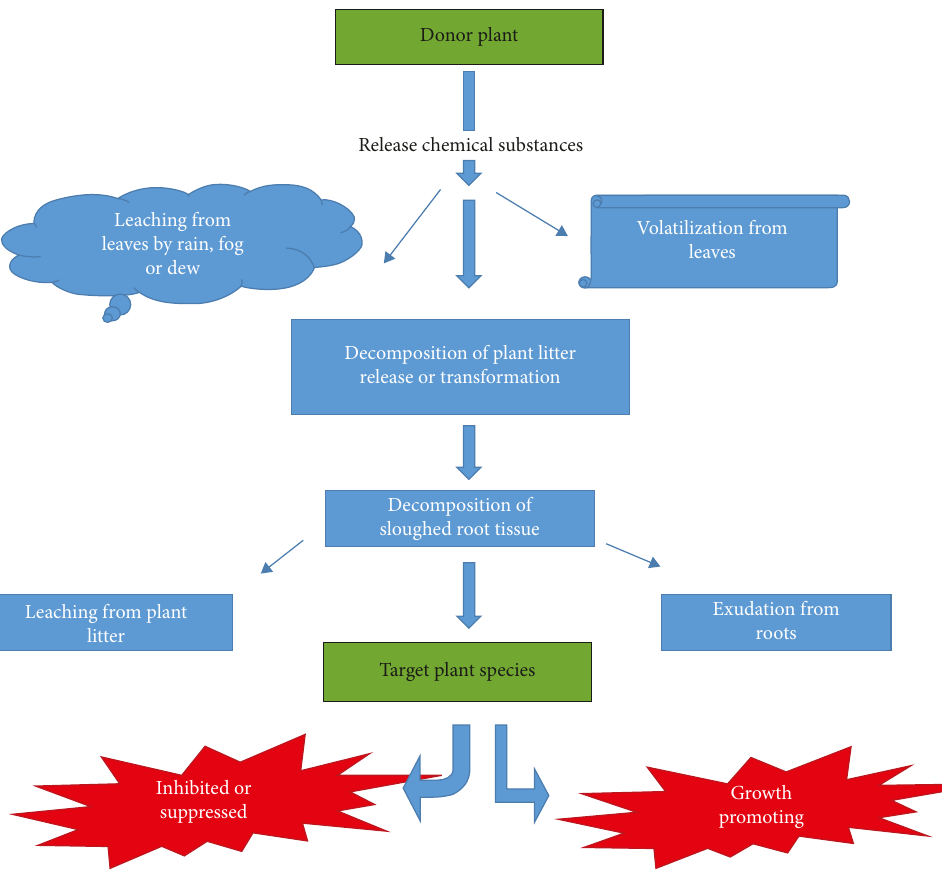
Figure 1: The routes by which allelochemicals may be released to the environment to inhibit and/or suppress other organisms or be stimulatory to